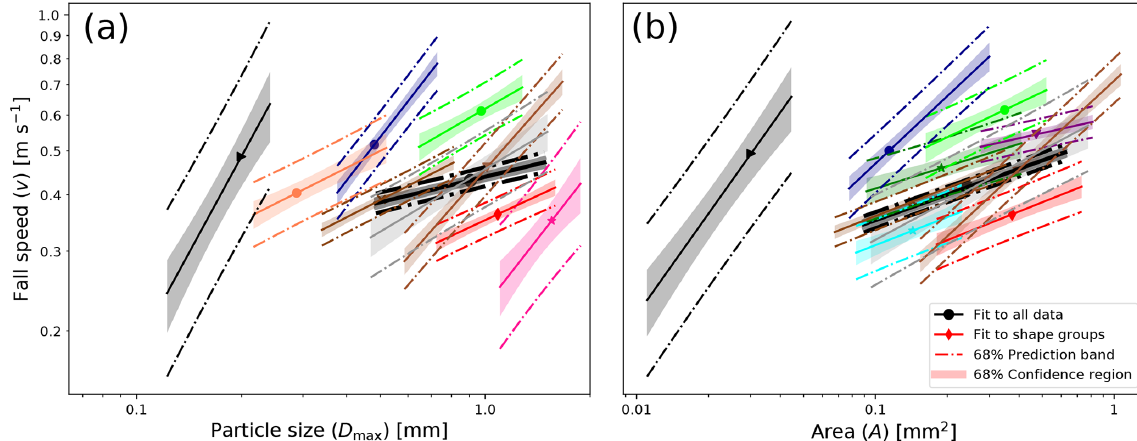
Figure 8. Fall speed vs. particle size ( v vs. D max ) and fall speed vs. cross-sectional area ( v vs. A ) relationships for the shape groups where we have found good correlations (solid lines) and all data regardless of shape (dashed black lines) are shown. The 68% prediction band and the 68% confidence region for the fits ( M b ) are also shown. For a legend of the shape groups, see Fig. 5. (a) v vs. D max relationship. Shape groups (5) , (6) , (7) , (8) , (11) , (12) , (13) , (14) , and (15) are displayed. The values of the median of D max are represented by points. (b) v vs. A relationship. Shape groups (1) , (4) , (5) , (7) , (8) , (9) , (11) , (12) , (14) , and (15) are displayed. The values of the median of A are represented by points. The length of the fit lines is defined by 16th and 84th percentiles of D max (a) and A (b) . The corresponding data are shown in Tables 3–4.